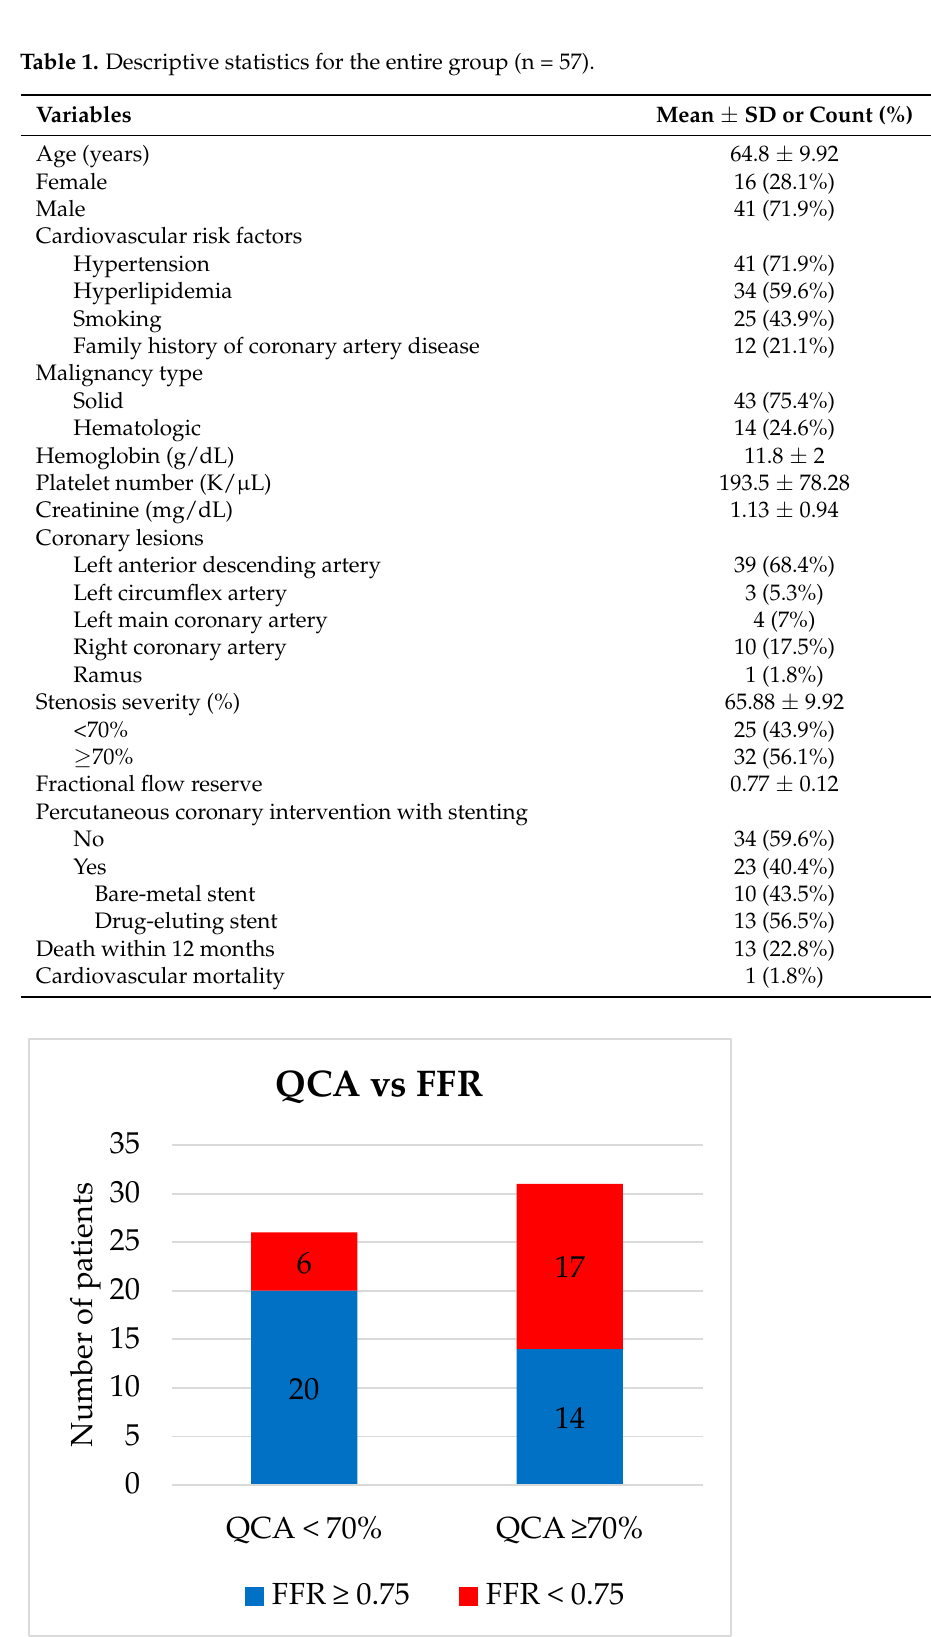
Figure 1. Coronary stenosis severity assessment via quantitative coronary angiography versus fractional flow reserve. QCA = Quantitative coronary intervention; FFR = Fractional Flow Reserve . Over a median of 43 months (95% confidence interval (CI) 31–53 months) of follow-